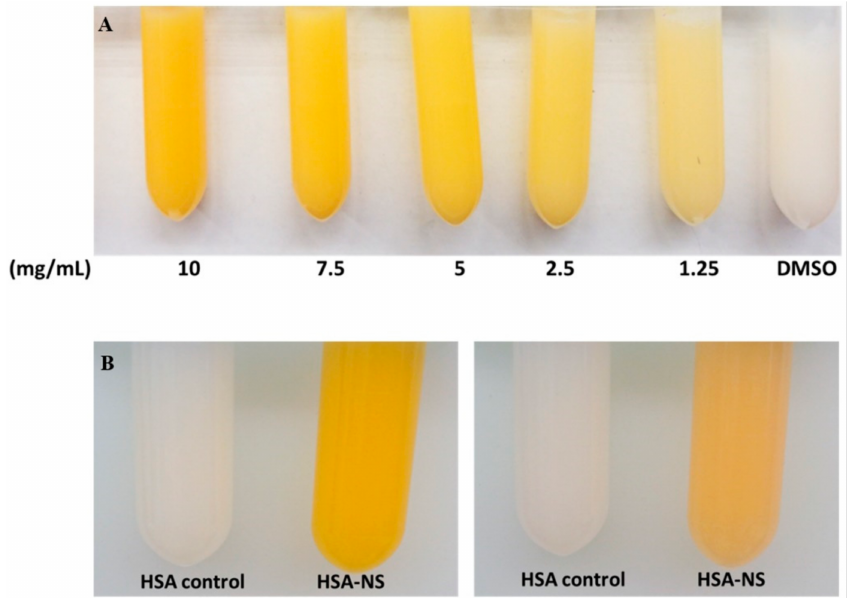
Figure 2. Non-sericin loaded human serum albumin micro particles (NS-HSA MPs) by CCD- technique. Non-sericin components were varied at different concentrations to increase the percentage of entrapment efficiency ( A ). Non-sericin samples were incubated ( B ) before the cross-linking step (left) and after the cross-linking step